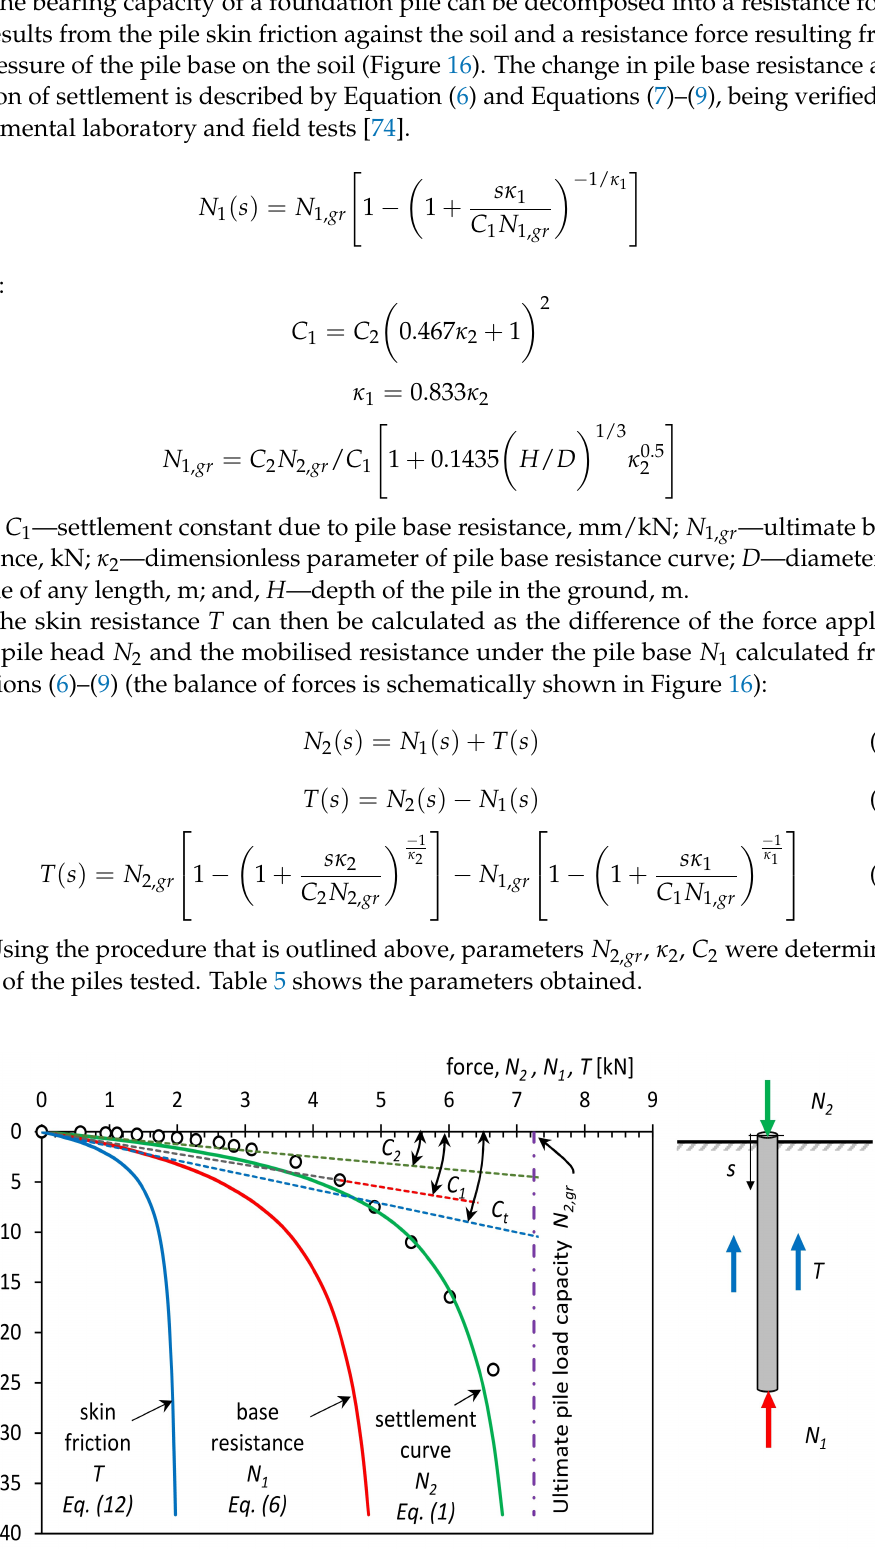
Figure 16. Measured settlement versus applied load—(dots) and calculated curves: settlement approximation curve (green line); base resistance curve (red line) and skin friction curve (blue line) of pile no